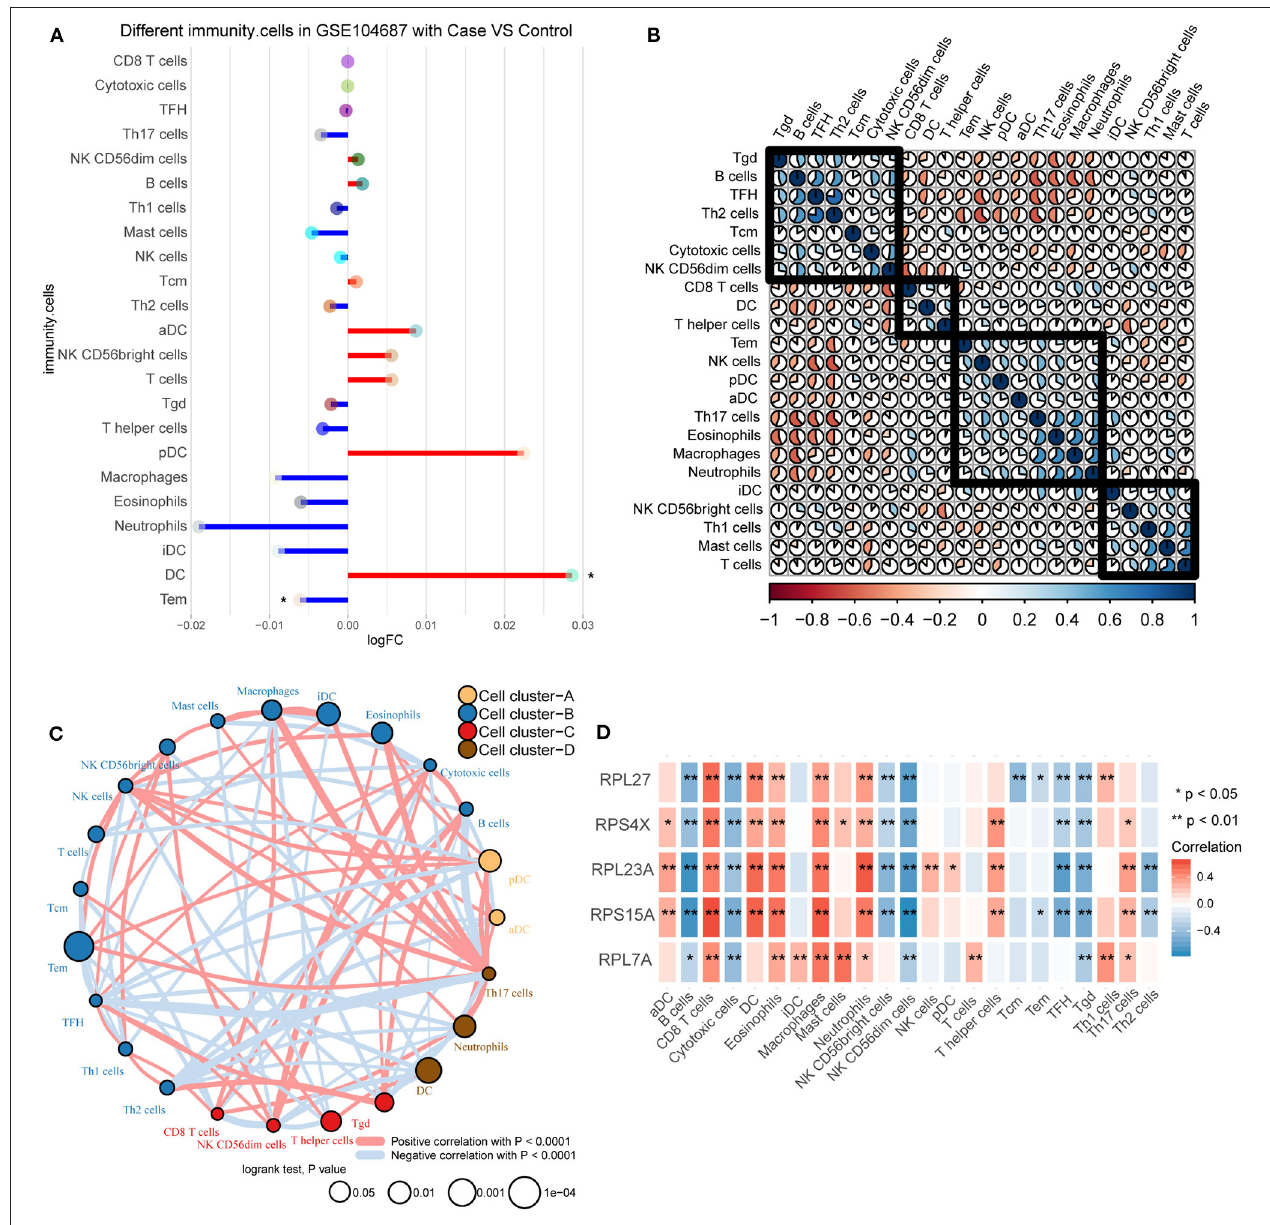
FIGURE 5 | Differences in immune infiltration between TBI and control. (A) Differences of immune cell infiltration between TBI and control in GSE104687. Red line represents up-regulation, and blue line represents down-regulation. (B) The correlation between immune cells. (C) The immune cells were clustered into four groups. (D) The correlation between immune cells and hub genes. Red is positive correlation, and blue is negative correlation. * P < 0.05, ** P < 0.01.